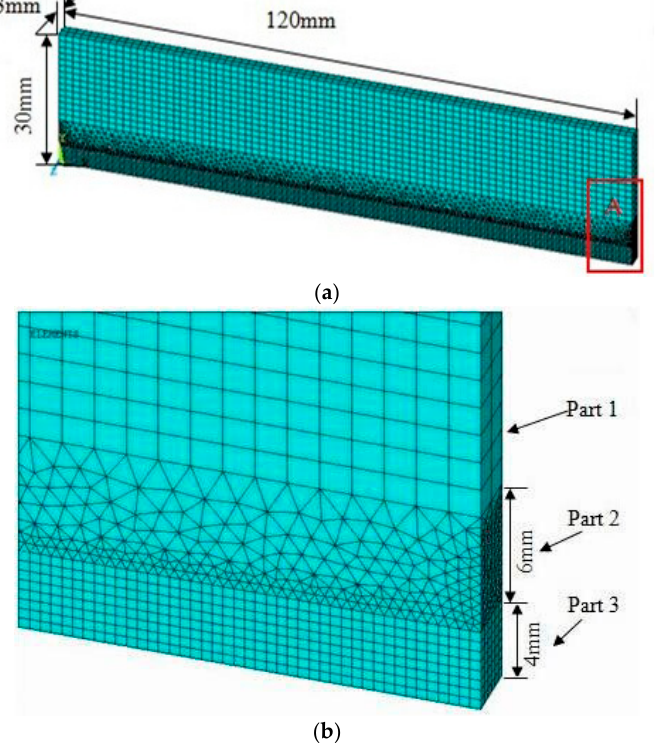
Figure 2. ( a ) The dimensions of the model and ( b ) the magnified chart of Region A.